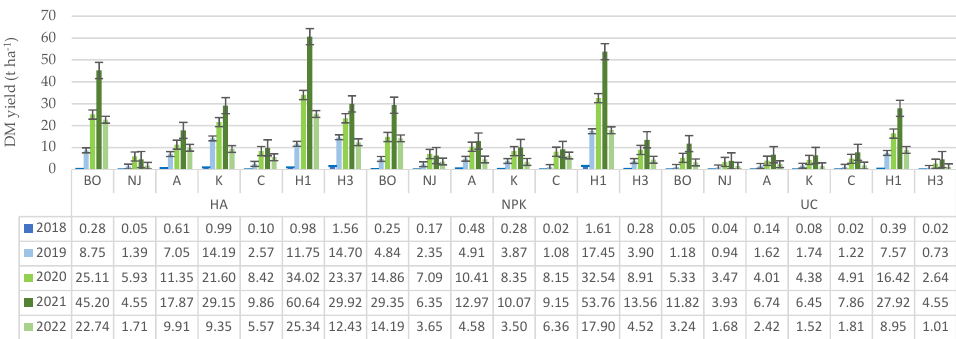
Figure 1. The dry matter yields according to cultivars and treatments. Authentic data with standard deviation are added.